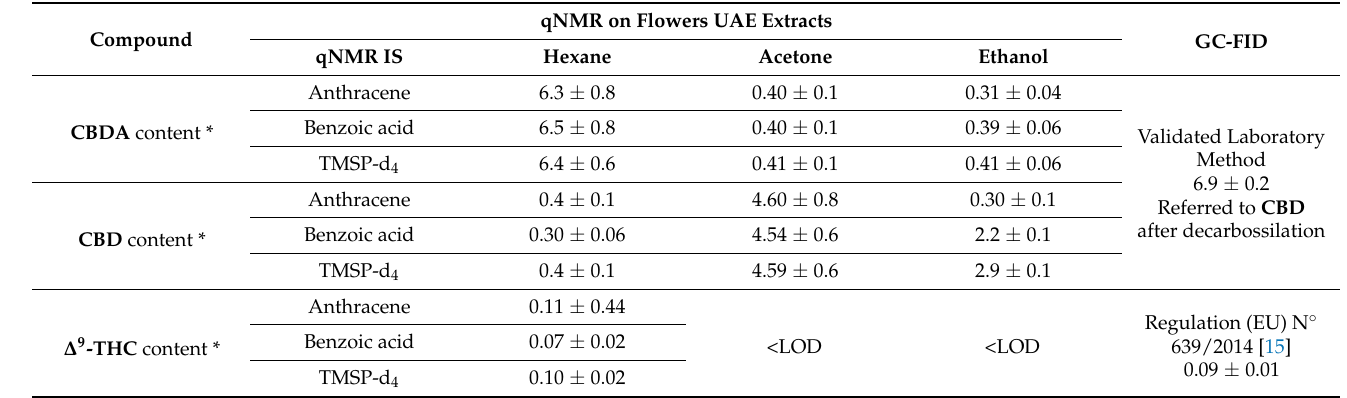
Table 3. 1 H NMR data of the main cannabinoids in Timborzallasi inflorescences compared with the GC-FID